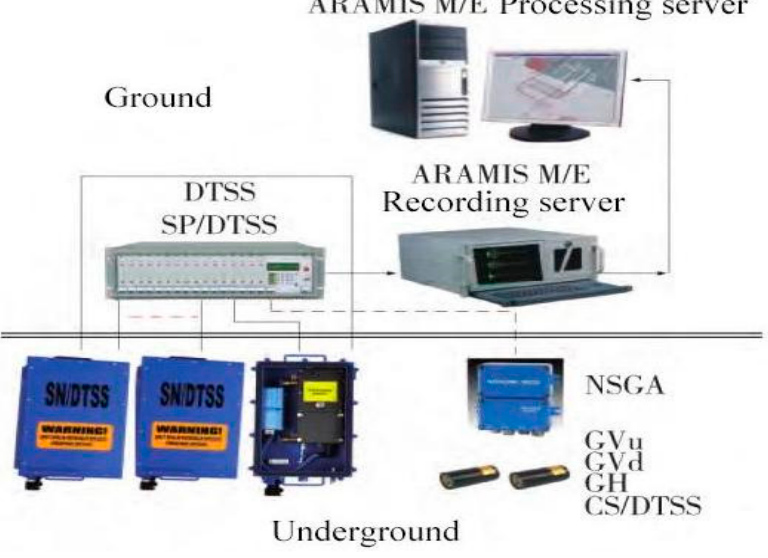
Figure 2. Microseismic system diagram.